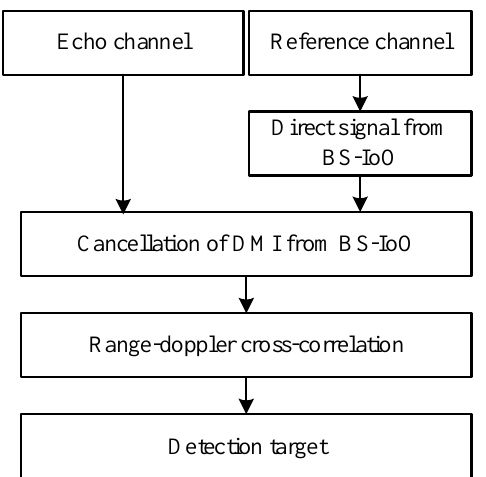
Figure 2. Traditional passive radar signal processing process.